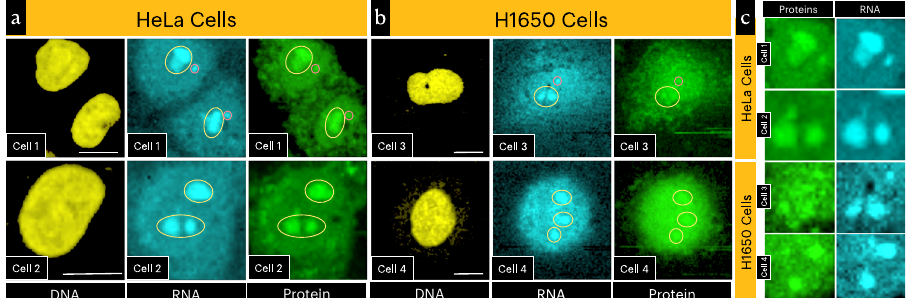
Fig. 2 Raman images showing DNA, RNA, and proteins distributions inside cells. a HeLa cells, b H1650 cells. Nucleoli are circled yellow and Cajal bodies are circled red. A line pro fi le from cell 2 is given in fi g. S9. c Zoomed images from Fig. 2a, b showing RNA and proteins aggregates observed inside nuclear regions. Identical shapes con fi rm their assignments to nuclear LLPS domains. In cell 3, however, the LLPS image correlation is comparatively poor. Scale bars 10 µ